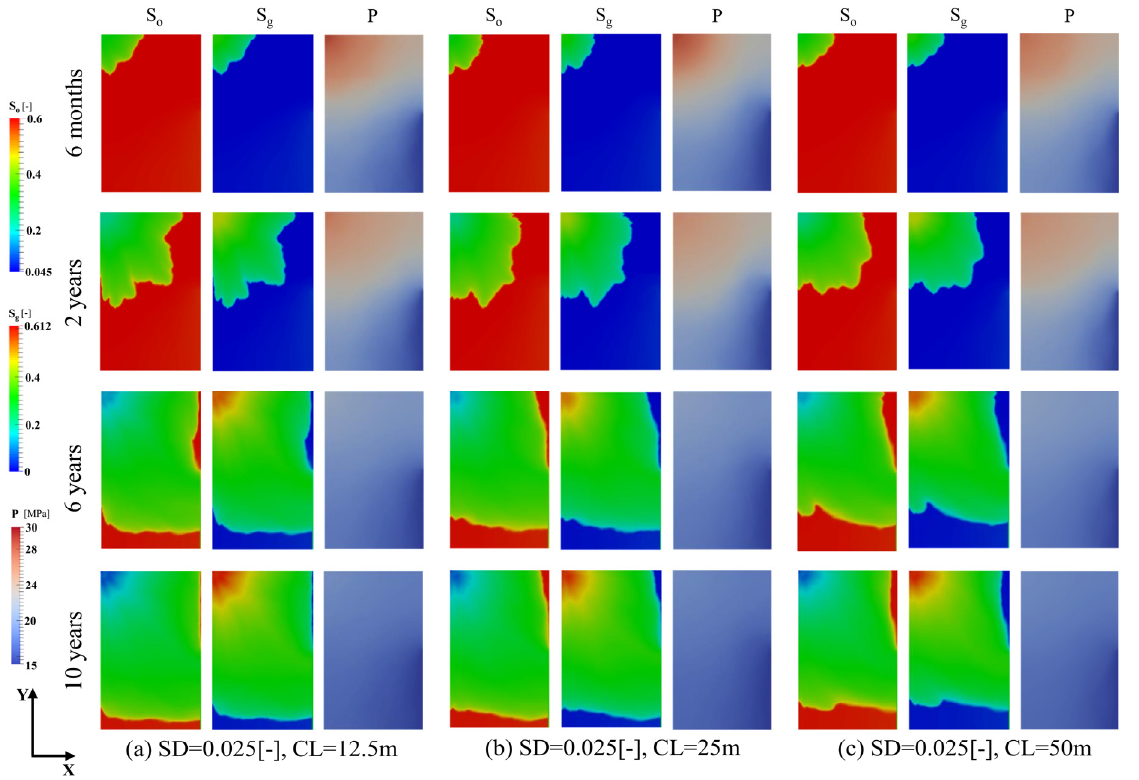
Figure 7. Evolutions of saturation and reservoir pressure fields in Set 1. ( a ) SD = 0.025 (-), CL = 12.5 m; ( b ) SD = 0.025 (-), CL = 25 m; ( c ) SD = 0.025 (-), CL = 50 m.